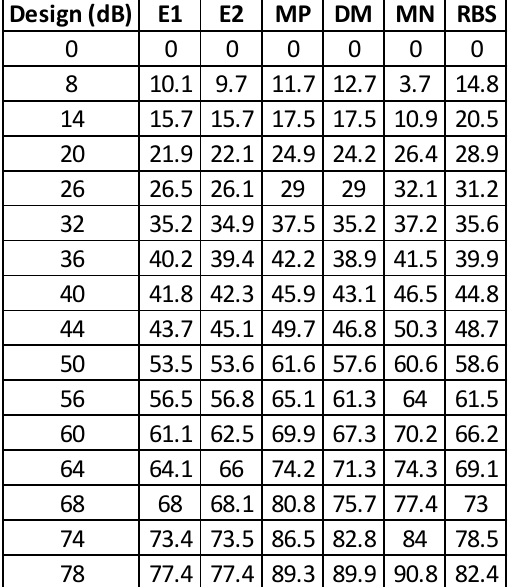
Table 1. Part 1: CMOS Camera Imaged E1 & E2 Data using Proposed Method versus 4